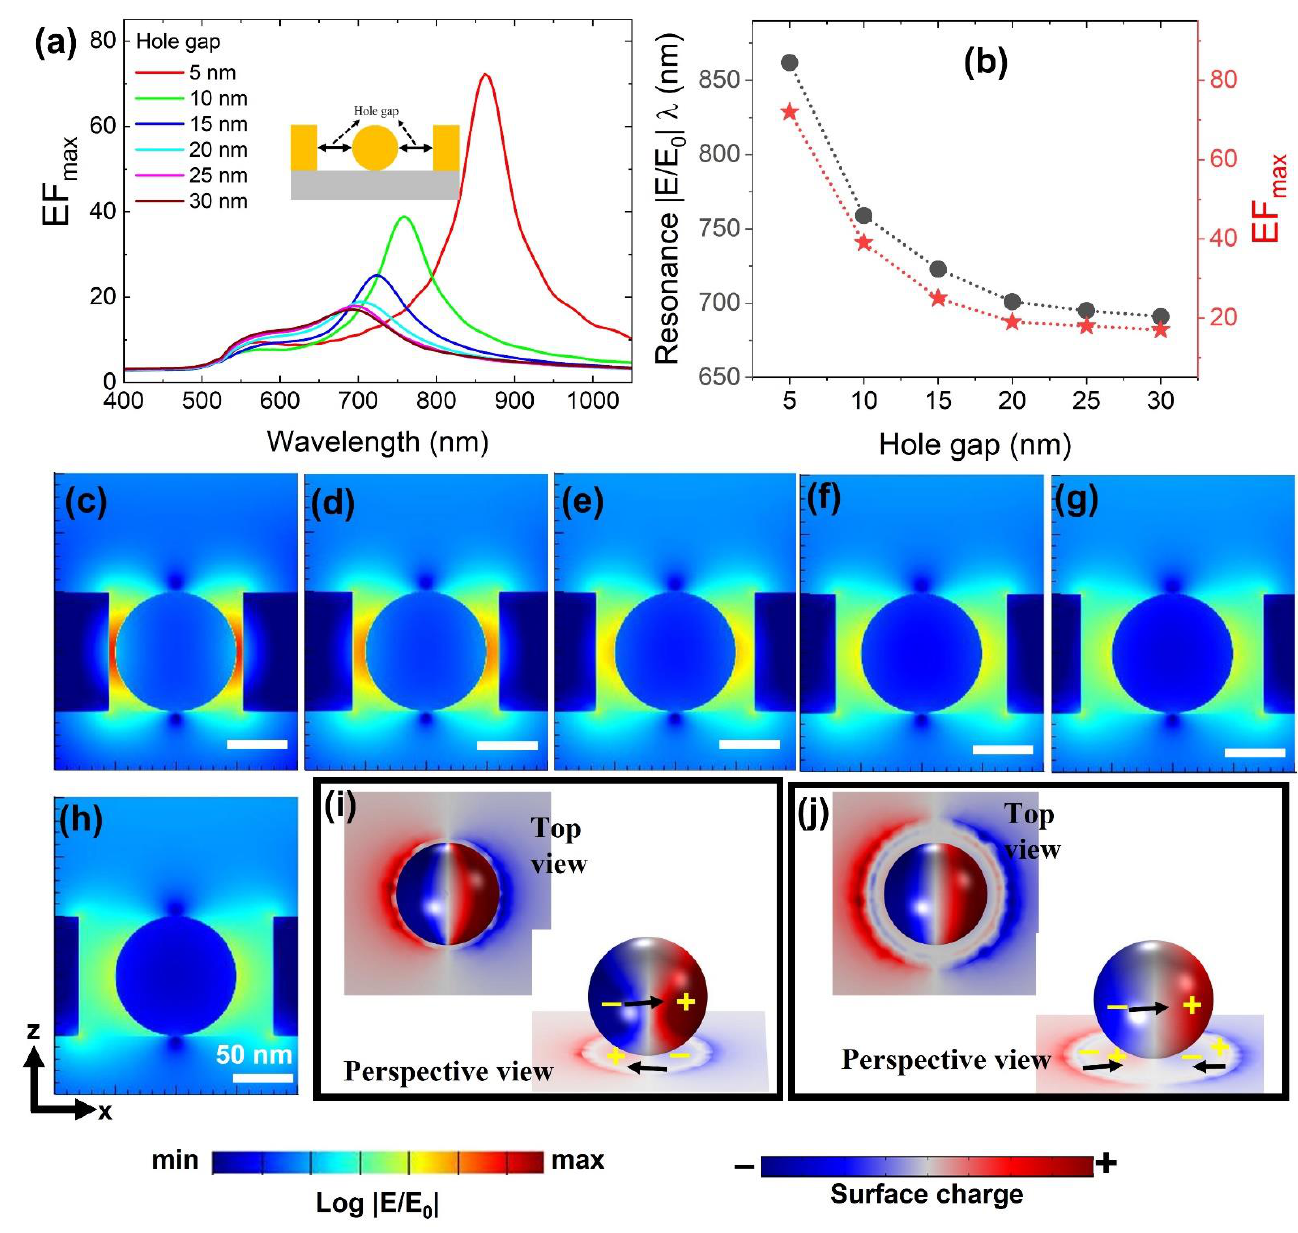
Figure 6. ( a ) Hole-gap size-dependent broadband near-field enhancement EF max spectra with the NP positioned at the bottom of a hole structure and ( b ) corresponding gap mode’s EF max and resonance wavelength positions. ( c – h ) Cross-sectional XZ electric field profiles extracted from wavelength positions as seen in Figure 4b as a function of hole-gap size ranging from 5 nm to 30 nm in 5 nm steps. Scale bars equal 50 nm. 3DSCDM profiles taken at hole-gap size of 5 nm ( i ) and 25 nm ( j ). For a perspective view, we hid the hole for clear visibility of charge interactions.